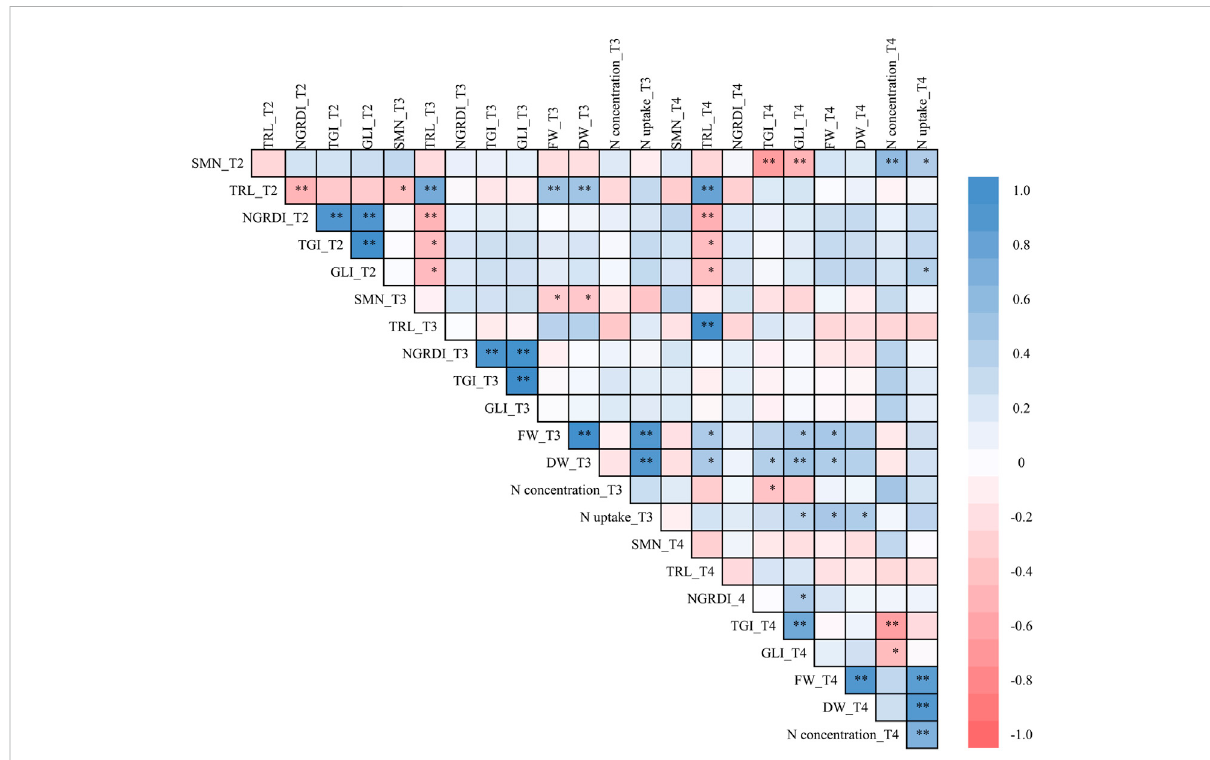
FIGURE 6 Pearson ’ s correlations between observations combing the three sampling moments T2 (9 July 2020), T3 (18 August 2020) and T4 (22 September 2020). * p < 0.05, ** p < 0.01, *** p < 0.001. FW, fresh weight (t ha − 1 ) of the harvested biomass; DW, dry weight (t ha − 1 ) of the harvested biomass; N concentration, crop N concentration (% DW) in theharvested biomass; N uptake, crop N uptake(kg ha − 1 )inthe harvested biomass; SMN, thetotalsoilmineralNcontent(kgha − 1 )at0 – 90 cmsoildepth;NGRDI,normalizedgreen-reddifferenceindex;TGI,triangulargreennessindex; GLI, greenness leaf index; TRL, the total root length (m) at 0 – 84 cm soil